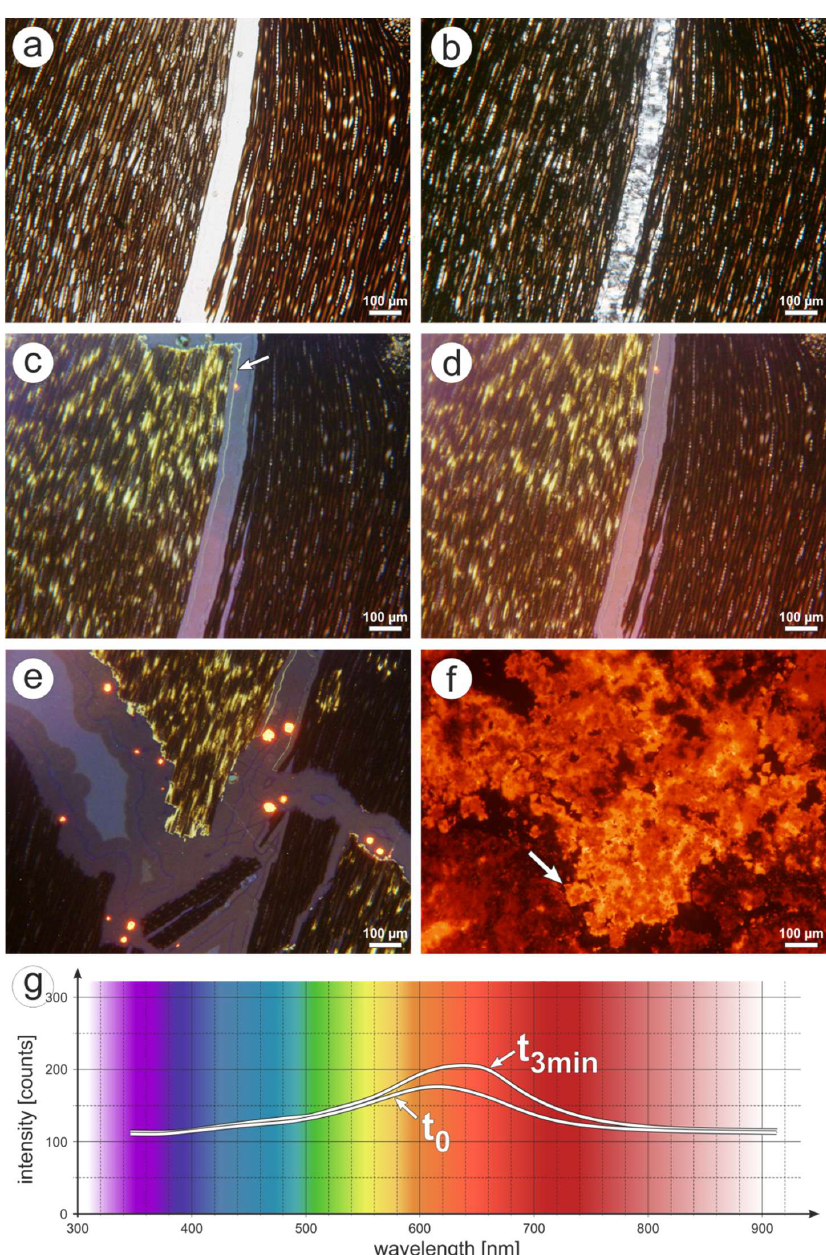
Figure 13. CL of 1977/7. ( a ) Radial section of the wood; PPL image. A longitudinally aligned fracture separates the wood along the tracheids. ( b ) Same photo as in (a); XPL image. Due to the strong inherent color of the organically preserved cell walls, the wood appears brown. The fracture is filled by two generations of quartz. ( c ) Initial CL image of a. The wood left of the fracture shows a yellow CL, whereas the fracture filling and the wood on the right side display a low intensity blue CL. Different generations of quartz within the fracture are indicated by yellow CL along their interface (arrow). ( d ) CL image after three minutes of irradiation. Note the shift to a red CL, whereas yellow CL is comparatively stable. ( e ) Initial CL image of a fracture dissecting the wood. The fracture filling is rich in less than 50 μm large calcite crystals showing an intense orange CL at 620 nm. ( f ) Initial CL image of the calcareous stromatolite encrustation, which is made up of 30 μm large euhedral calcite crystals (arrow). ( g ) CL spectra of silica showing a lowly intense, time-dependent color taken initially (t 0 ) and after three minutes of irradiation (t 3min ). Each curve resulted from interference of three different luminescences: blue (440 nm), yellow (580 nm; diffracted radiation from neighboring areas) and red (650 nm). Note increasing intensity of red CL with time.